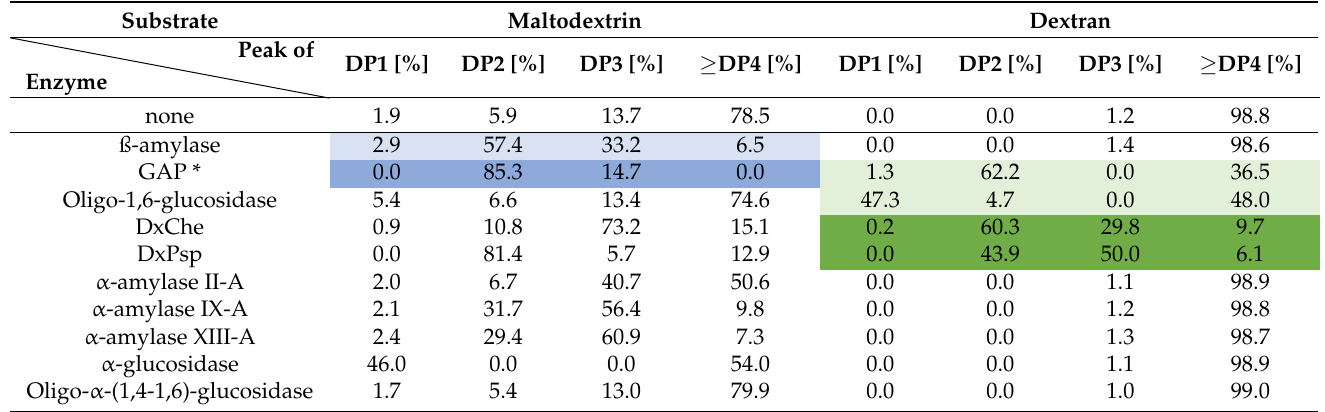
Table 1. Effectivity of 10 commercially available glucoside hydrolases for degradation of maltodex- trins and dextrans is compared by abundancies of mono- and oligosaccharides before and after treatment in disodium phosphate-citrate buffer at pH 5 for 1 h at 37 ◦ C. Percentages of maltodextrins and dextrans were calculated after automatic peak picking with glyXtoolCE™. The most efficient enzymes for maltodextrin degradation are highlighted dark (best) and light blue (second best). The most efficient enzymes for dextran degradation are highlighted dark (best) and light green (second- best). GAP: glucoamylase P; DxChe: Dextranase from Chaetomium erraticum ; DxPsp: Dextranase from Penicillium species. * GAP was used with a concentration of 0.17 U/ µ